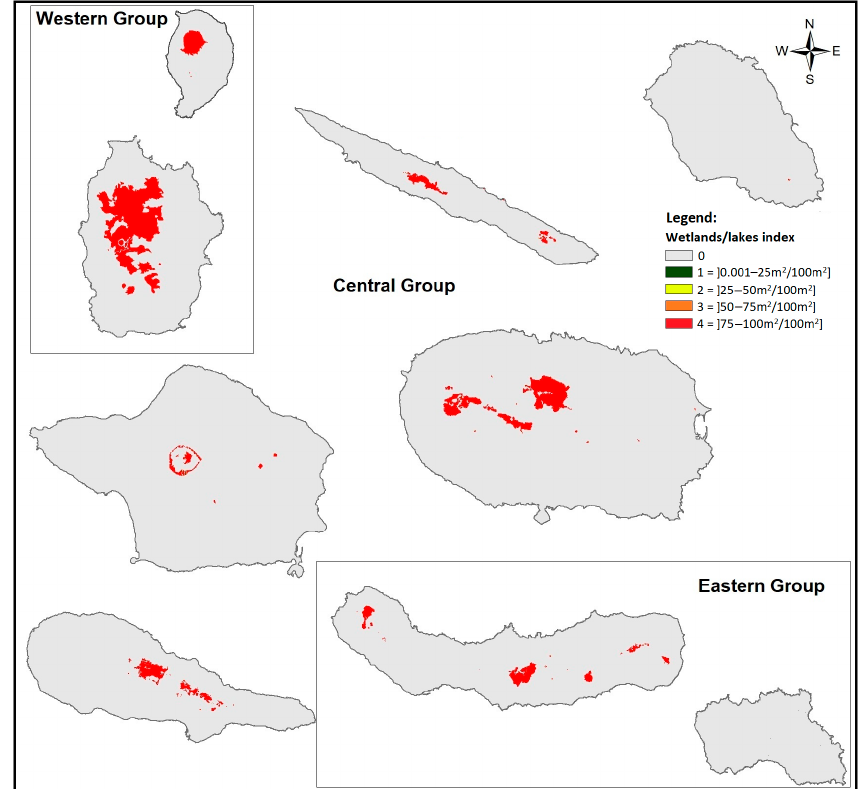
Figure 3. Mapping of the variables that compose the ecosystem dependence index: wetlands/lakes.